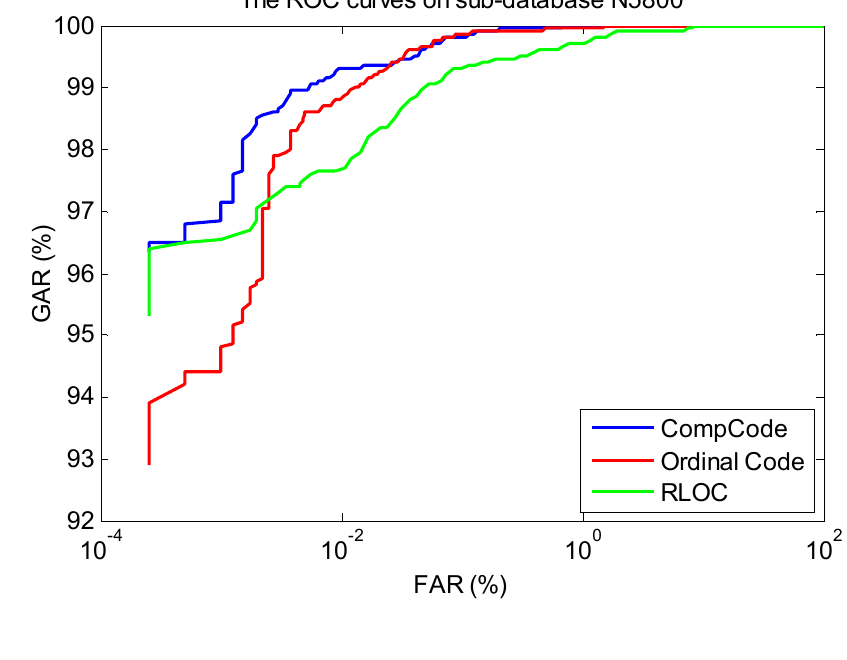
Figure 10. The ROC curves of methods Comp Code, Ordinal Code and RLOC on sub-database N5800 (using the 1~3 samples of the first session as the training